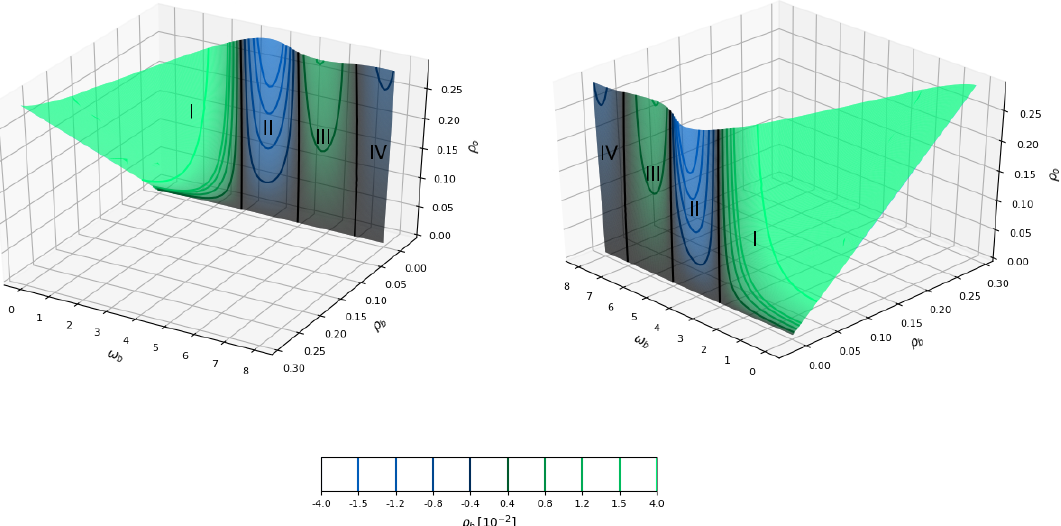
Figure 32 . The surface of time-periodic geometries responding to a periodically driven real scalar (cid:12)eld. The surface traverses the nonlinear oscillon plane (cid:26) b = 0 at a set of curves. This plot corresponds to the one on (cid:12)gure 2, to which the similarity is evident. The range exhibited is considerably smaller in this plot and this is due to the higher technical di(cid:14)culty in computing each solution